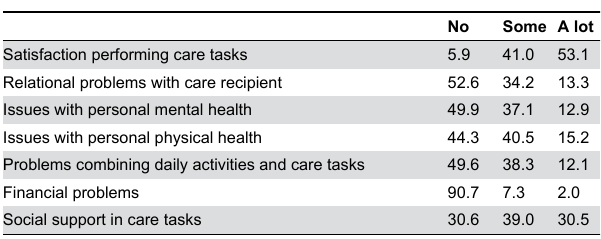
Table 5. Percentage of caregivers reporting problems on the CarerQol-7D quality of life scale (n=3,940), The Older Persons and Informal Caregivers Minimal DataSet, Netherlands,